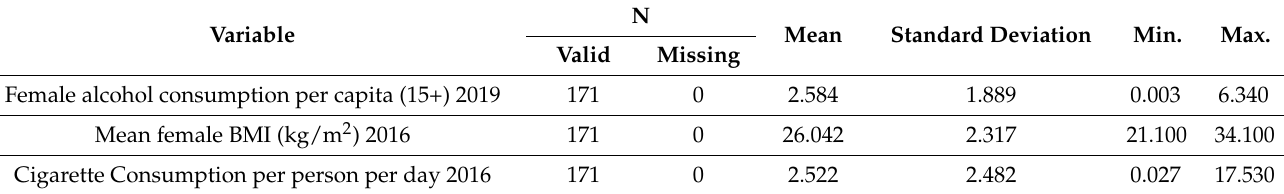
Table 1. General situation of the independent variables.